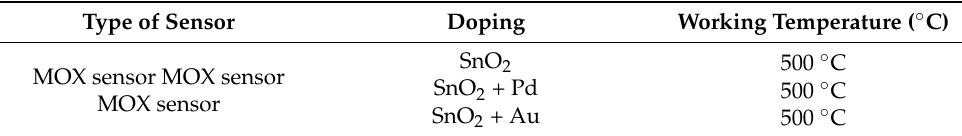
Table 1. Schematic description of the setup for different sensing